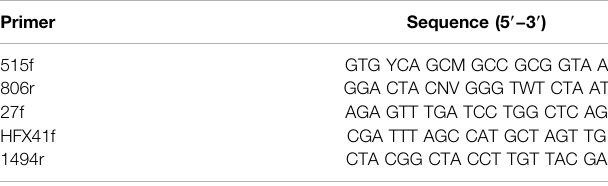
TABLE 1 | Primers used for genetic